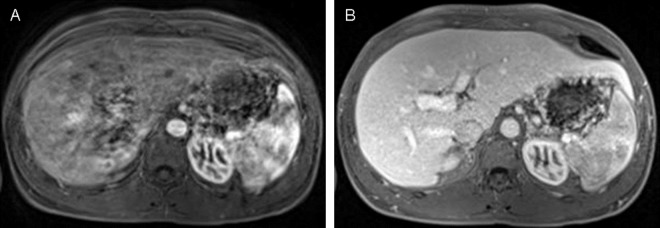
27 year old male patient with diagnosis of primary sclerosing cholangitis.Gadoxetate disodium-enhanced liver MRI in the arterial (A) and portalvenous phase (B). Self-limiting severe transient motion can be appreciated in the arterial phase, causing significant degradation of image quality, which is resolved in the portalvenous phase.